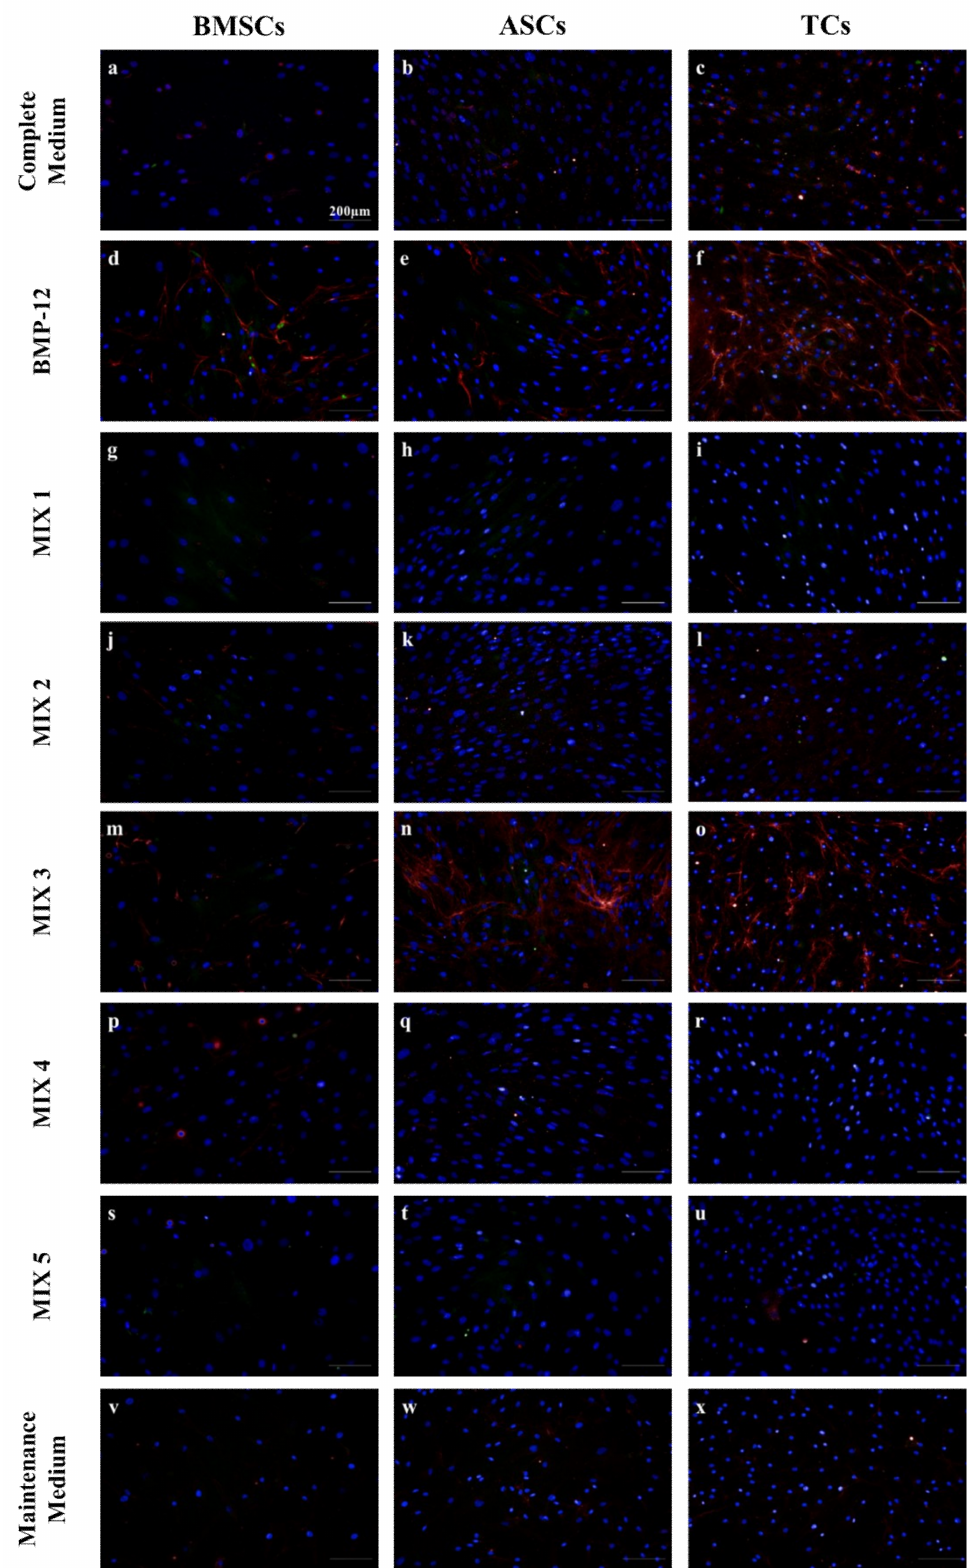
Figure 1. SCX and DCN immunofluorescence assays of BMSCs, ASCs and TCs cultured in different tenogenic media. Representative micrographs of BMSCs (a-d-g-j-m-p-s-v), ASCs (b-e-h-k-n-q-t-w) and TCs (c-f-i-l-o-r-u-x) after three days of culture in different tenogenic media. Cells were stained for DCN (red), SCX (green) and DNA (Blue). Scale bars = 200 µ